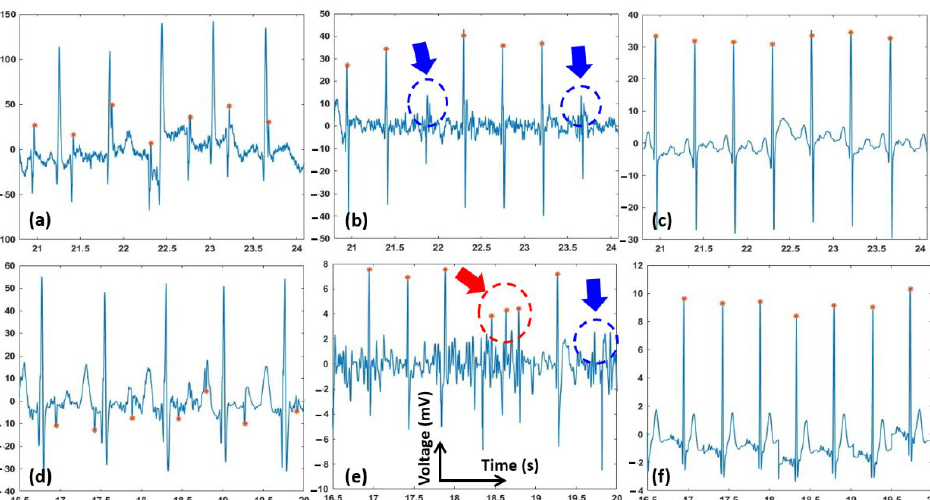
Figure 4. fECG extraction using the EKF and EnKF with the PhysioNet data. The fQRS annotation is shown in orange asterisk (*). The red arrows show the places that fetal QRS was wrongly detected. The blue arrows show the missing fetal QRS. ( a ) Abdominal ECG (raw data) of record “a03”; ( b ) fECG extracted using EKF of record “a03”; ( c ) fECG extracted using EnKF of record “a03”; ( d ) Abdominal ECG (raw data) of record “a01” with reversed fetal QRS complexes; ( e ) fECG extracted using EKF of record “a01”; ( f ) fECG extracted using EnKF of record “a01”.